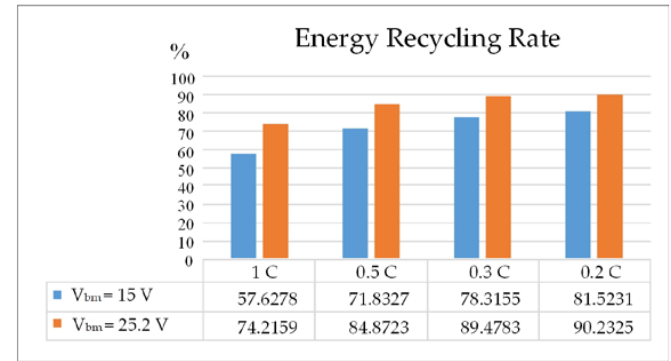
Figure 15. The energy recycling rate under various test conditions.